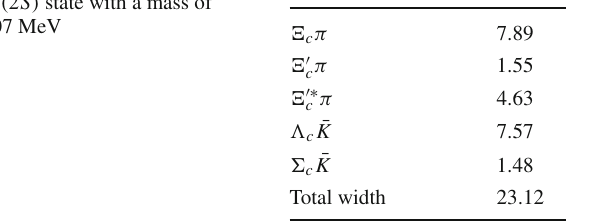
Table 5 Strong decays of the (cid:2) (cid:2)∗ ( 2 S ) state with a mass of c 3007 MeV